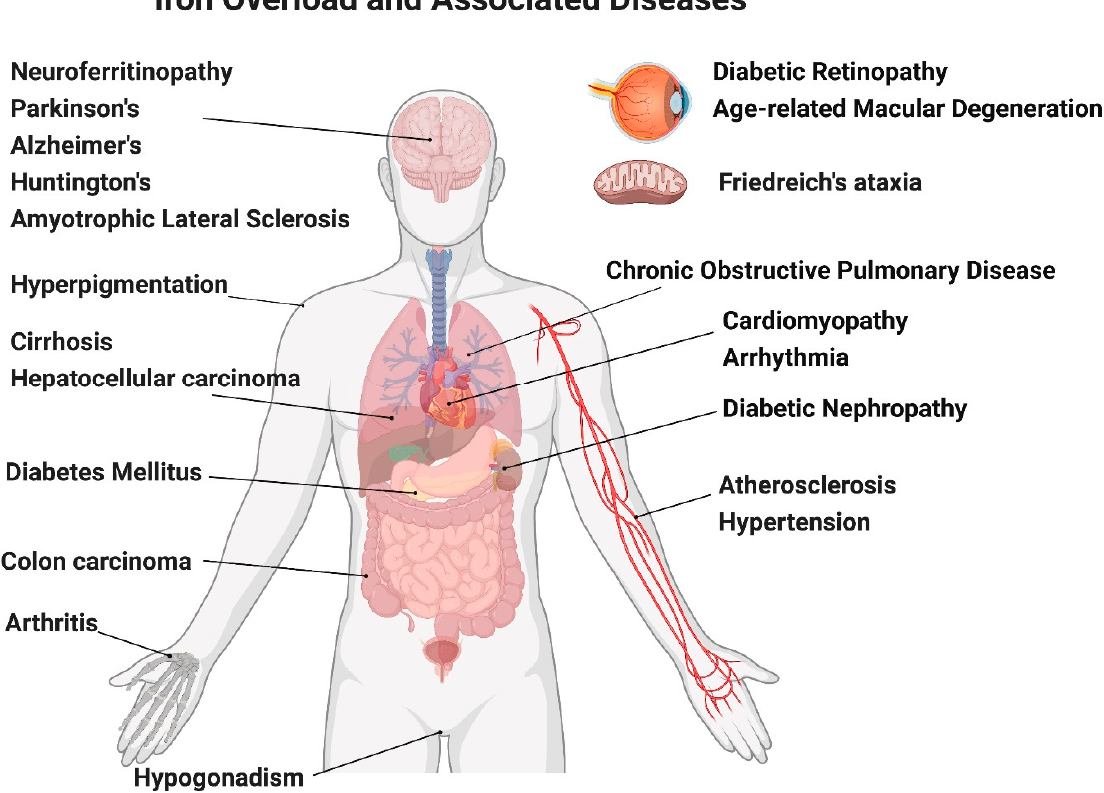
Figure 1. Illustration of iron overload associated diseases. Created with BioRender.com (accessed date: 15 April 2022).